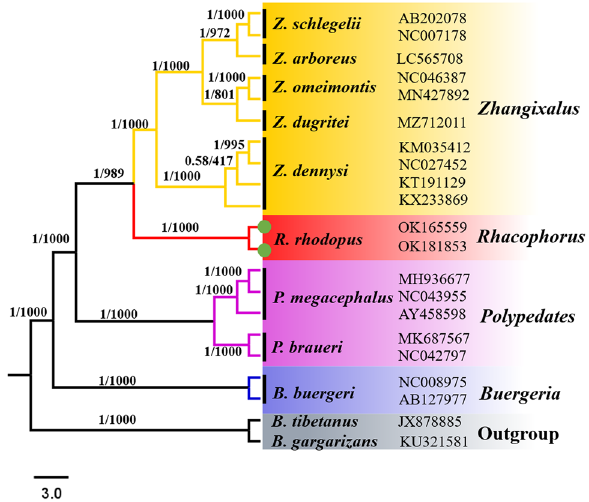
Figure 5. BI and ML analysis of 11 species complete mitochondrial genome sequence, Bufo gargarizans and Bufo tibetanus as outgroups. Tree topologies produced by BI and ML analyses were equivalent. Bayesian posterior probability (PP) and bootstrap support (BP) values for ML analyses are shown in order on the